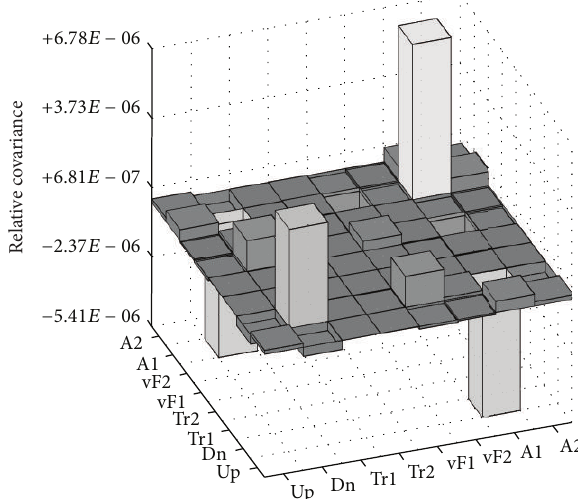
Figure 26: Homogenized property covariance due to infinite- dilution 𝜎 U 235 𝛾 covariance.